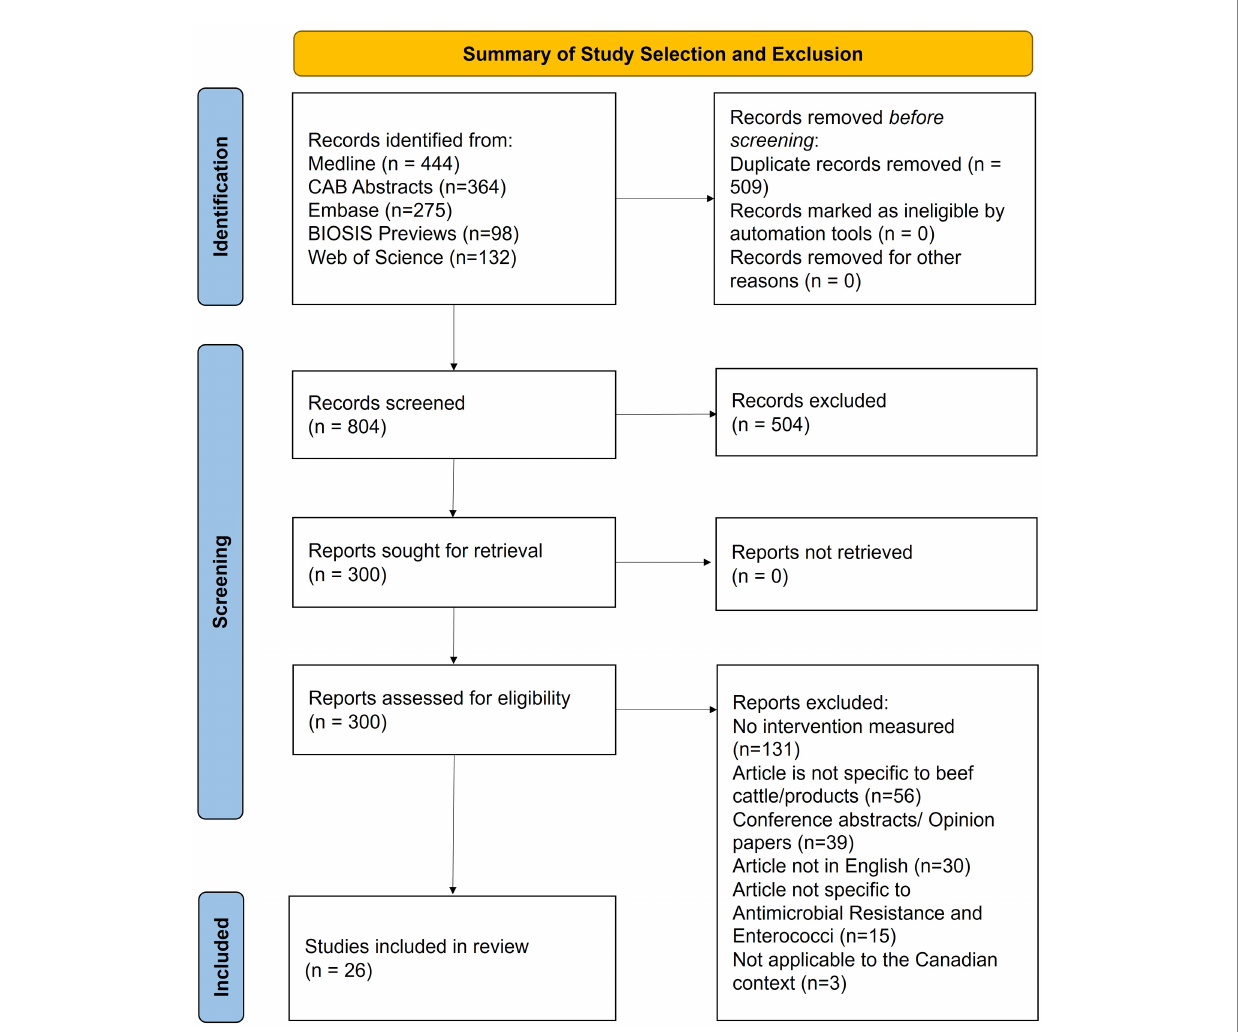
FIGURE 1 PRISMA-ScR flow diagram of the stages of article selection for inclusion in the Scoping review of reported factors associated with antimicrobial resistant enterococci in Canadian beef